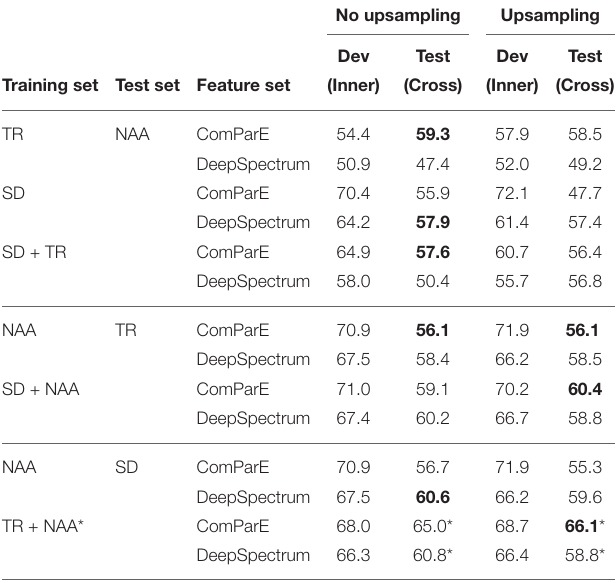
TABLE 5 | Results with the NAA Agg labels.